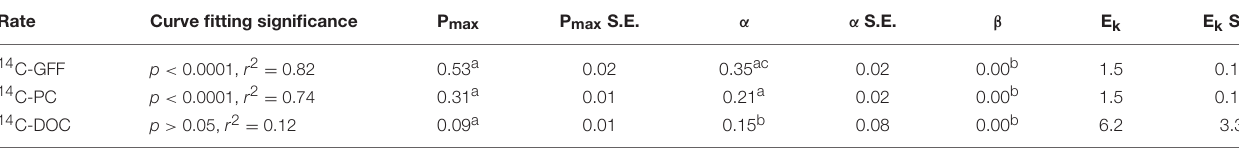
Parametersderivedfor 14 C-GFFand 14 C-PCfromdatacollectedOctober2004–October2007andApril2010–October2012; 14 C-DOCparametersfromdatacollectedApril2010–April 2013. Significance (p-value) and coefficients of determination (r 2 ) for regression analyses are shown, along with derived parameters and standard error (S.E.). Units for P max , α , β , and